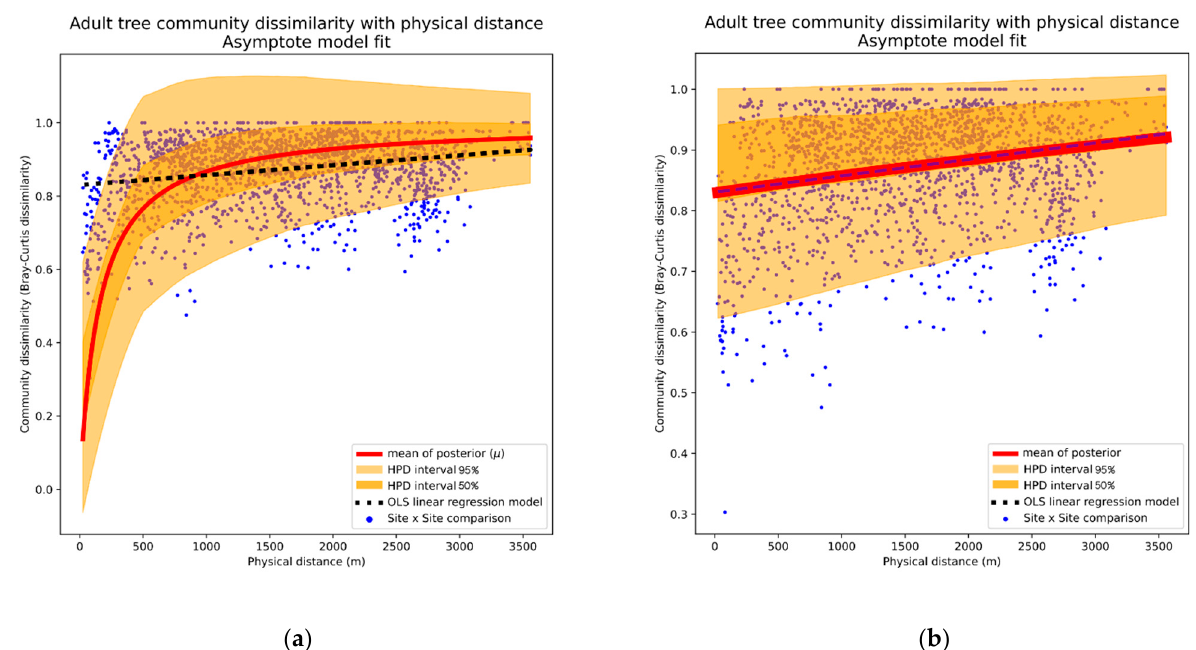
Figure 2. Community turnover and community dissimilarity models. Blue points represent Bray– Curtis dissimilarities between tree communities among all 61 sites, with increasing physical distance between sites being compared. Two approaches are considered, an asymptotic model and a simple linear model. ( a ) Bayesian, asymptotic (Michaelis–Menten) model fit. In this model, the function of the mean community dissimilarity value of zero was enforced when comparing sites that were nearly zero meters apart, and asymptotically approached complete dissimilarity (Bray–Curtis dissimilarity = 1). For comparison, the classical ordinary-least-squares fit is also given (black dashed line). ( b ) Bayesian linear model